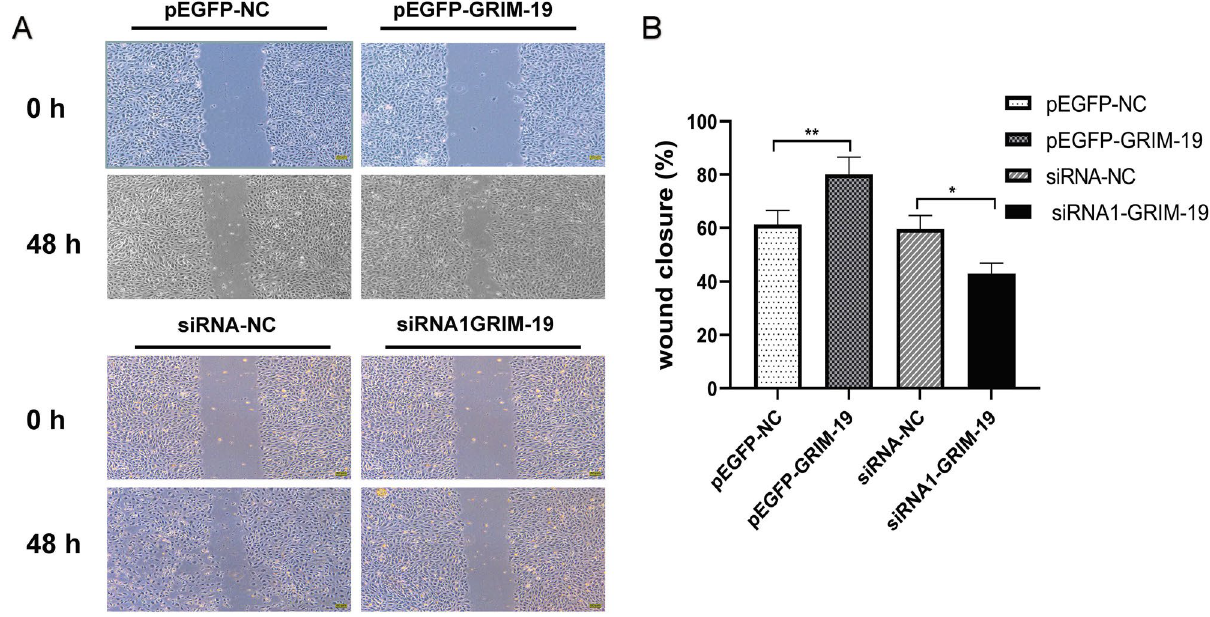
Figure 6. Scratch test to assess the migration of GC-2 spd cell at 0 h and 48 h. The percent of migrated pEGFP-NC and pEGFP-GRIM-19 cells (60.2 ± 5.3% vs 79.8 ± 6.1%, P < 0.01), the percent of migrated siRNA-NC and siRNA-GRIM-19 cells (57.6 ± 5.1% vs 43.2 ± 4.6%, P <